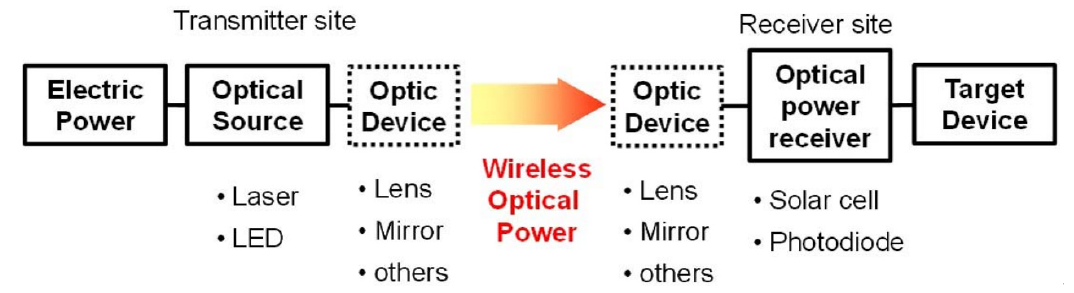
Figure 25. System block diagram of OWPT [100].